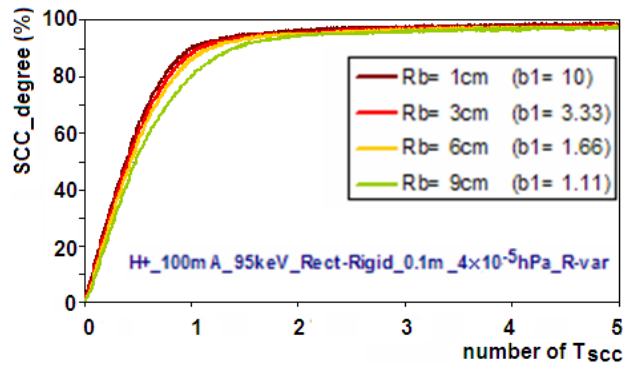
FIG. 7. (Color) SCC degree of the H (cid:2) beam at 4 (cid:7) 10 (cid:2) 4 and 4 (cid:7) 10 (cid:2) 5 hPa